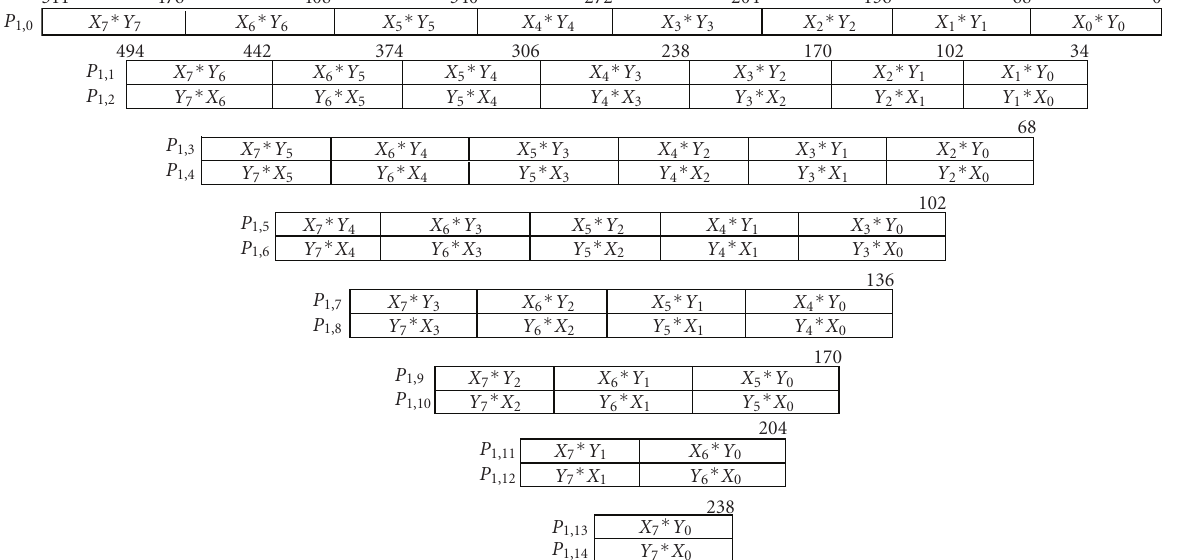
Figure 8: The segmented partial products of a 256 × 256-bit multiplier.